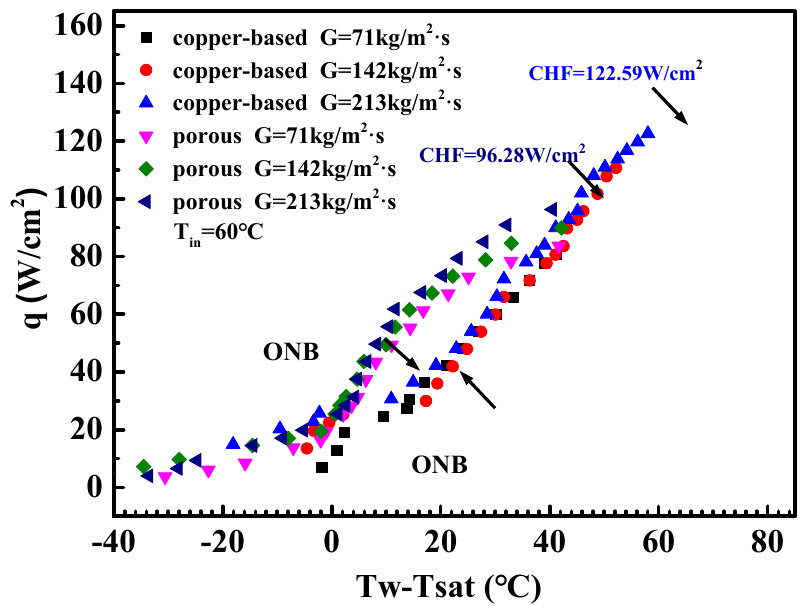
Figure 4. The boiling curves of the porous microchannels. ONB: onset of nucleation